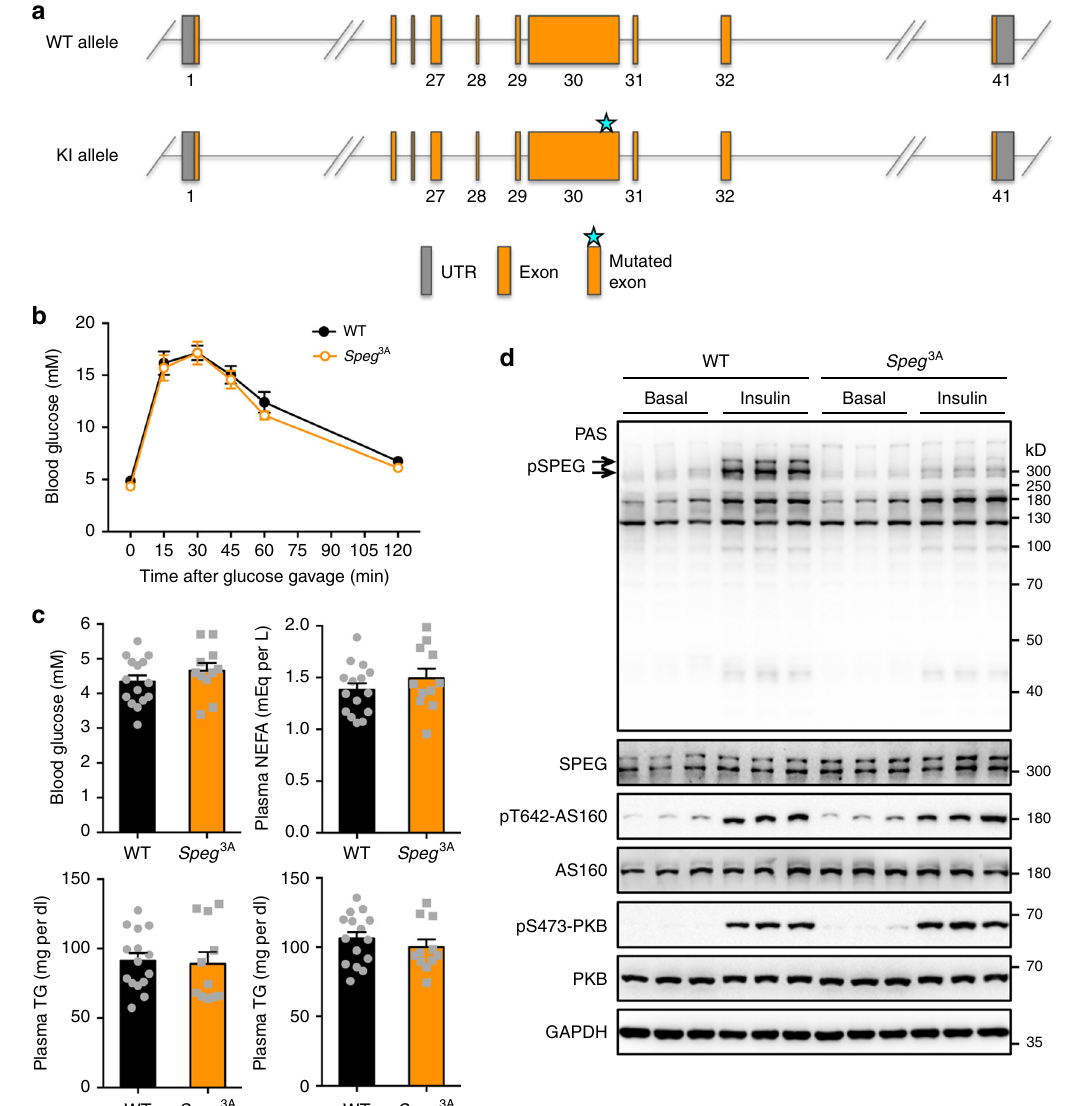
Fig. 7 Generation and basic characterization of the Speg 3A -knockin mice. a Diagram of strategy for generation of the Speg 3A -knockin mice. The cluster of serine/threonine residues Ser 2461 /Ser 2462 /Thr 2463 (the surrounding sequence is LAVRRRLsstLERL, Ser 2461 /Ser 2462 /Thr 2463 shown in lower case, and numbering is according to NP_031489.4) on SPEG was substituted to alanine by point mutagenesis. b Oral glucose tolerance test in the male Speg 3A - knockin mice and wild-type littermates (9-month-old). n = 5 (WT) and 6 ( Speg 3A ). p = 0.050 (0 min), 0.799 (15 min), 0.996 (30 min), 0.718 (45 min), 0.244 (60 min), and 0.134 (120 min). c Levels of glucose, non-esteri fi ed fatty acids (NEFA), triglycerides (TG) and total cholesterol (TC) were determined in the blood of male Speg 3A- knockin mice and wild-type littermates (8-month-old) after an overnight fast. n = 15 (WT) and 11 ( Speg 3A ). p = 0.270 (blood glucose), 0.317 (plasma NEFA), 0.819 (plasma TG), and 0.412 (plasma TC). d SPEG expression and PAS-reactive phosphorylation in the heart of WT and Speg 3A -knockin mice in response to insulin. The data are given as the mean ± SEM. Statistical analyses were carried out using two-sided t -test. Source data are provided as a Source Data fi